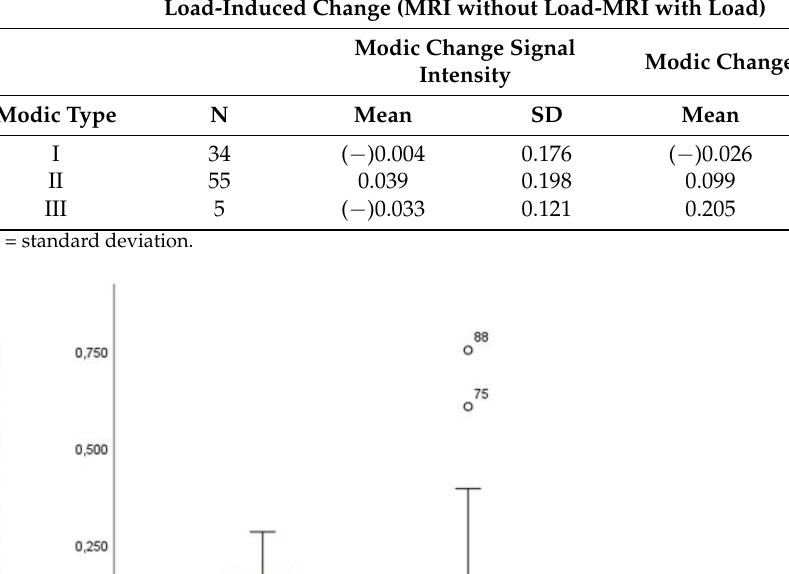
Table 3. Change in Modic volume and signal intensity between magnetic resonance imaging acquired with and without spinal loading for different Modic types.